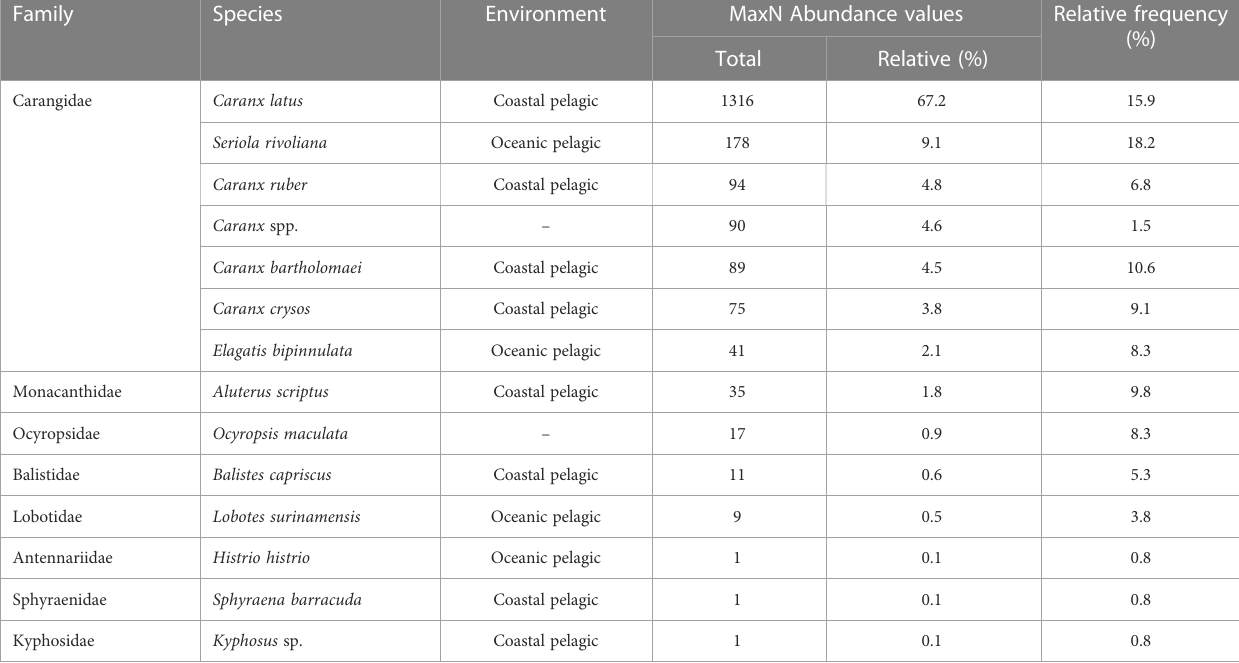
TABLE 1 Total and relative abundance and frequency of free-swimming fauna observed under pelagic sargassum by family and species.